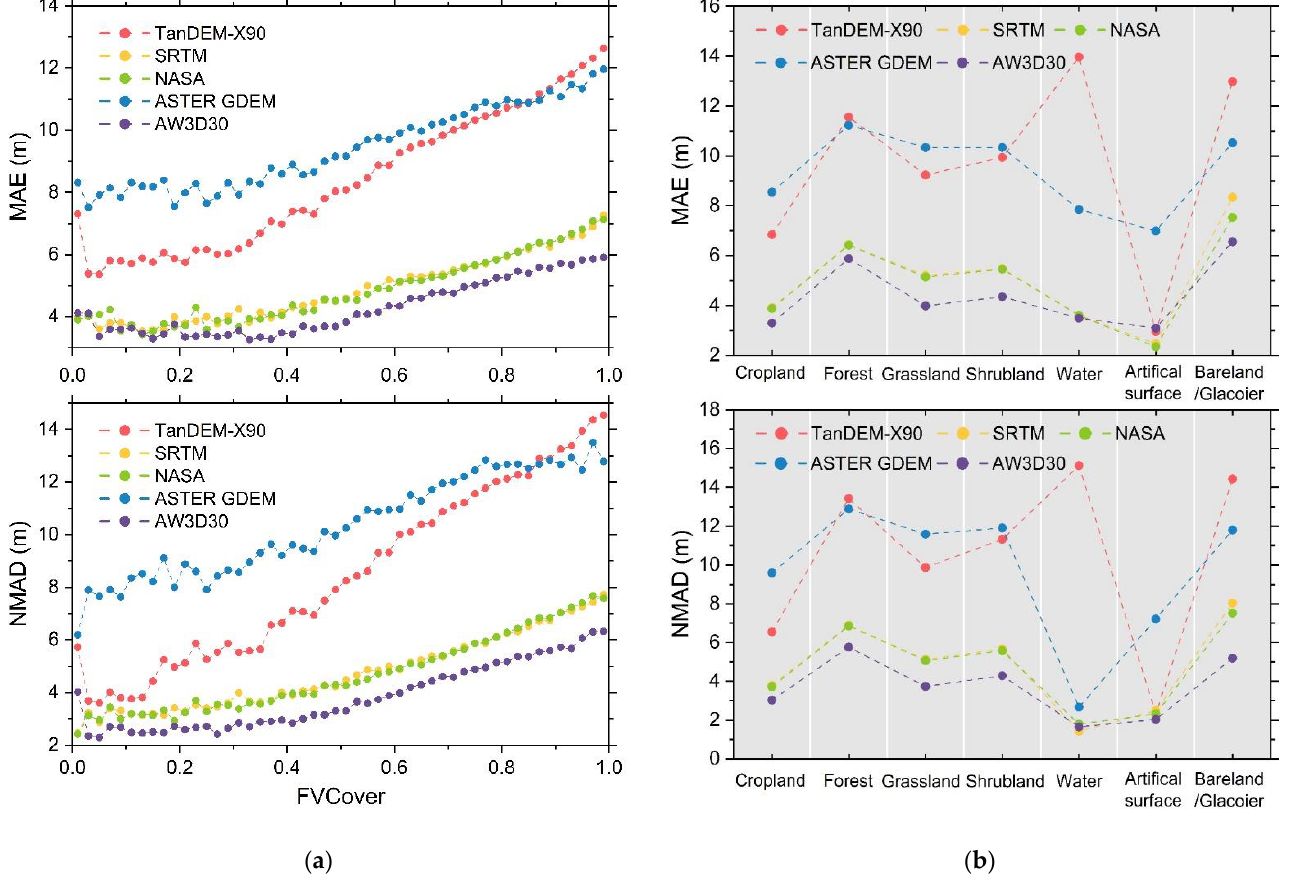
Figure 11. Relationship between quality indicators (( top ) MAE and ( bottom ) NMAD ) and ( a ) FVCover ( b ) landcover types.